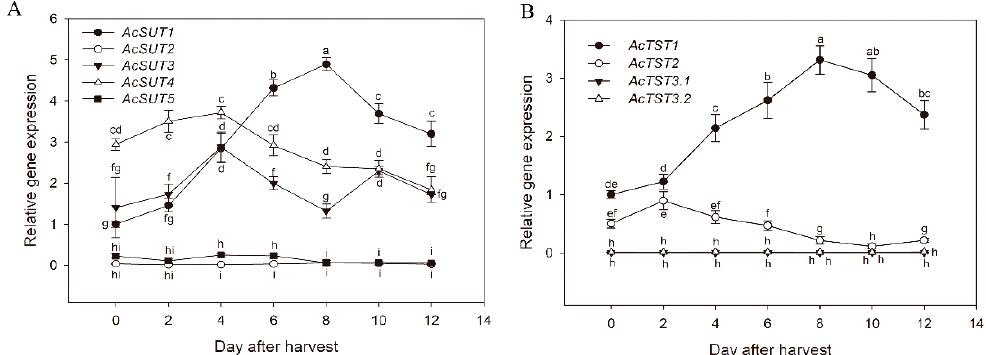
Figure 7. Expression patterns of AcSUTs and AcTSTs during postharvest kiwifruit ripening. The stages were 0, 2, 4, 6, 8, 10, and 12 days after harvest (DAH). The error bars represent the means ± standard deviation from three independent biological replicates. The bars with the same letter are not significantly different at the 0.01 level according to the student’s t -test. For each family, the expression level of the first member in each figure at 0 DAH was set to ‘1 ′ .